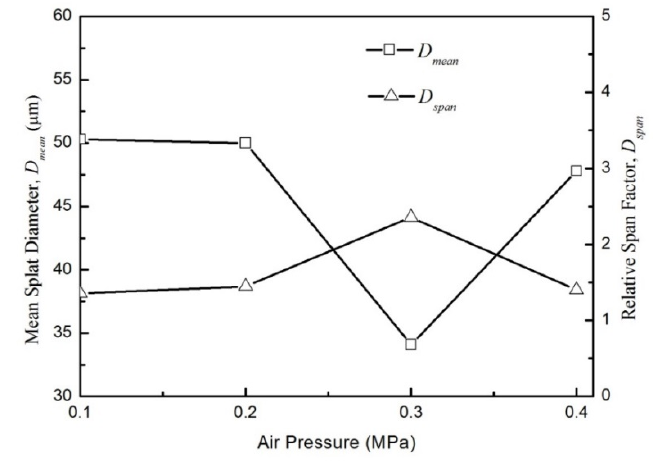
Figure 11. Mean splat diameter D mean and relative span factor D span versus carrier air